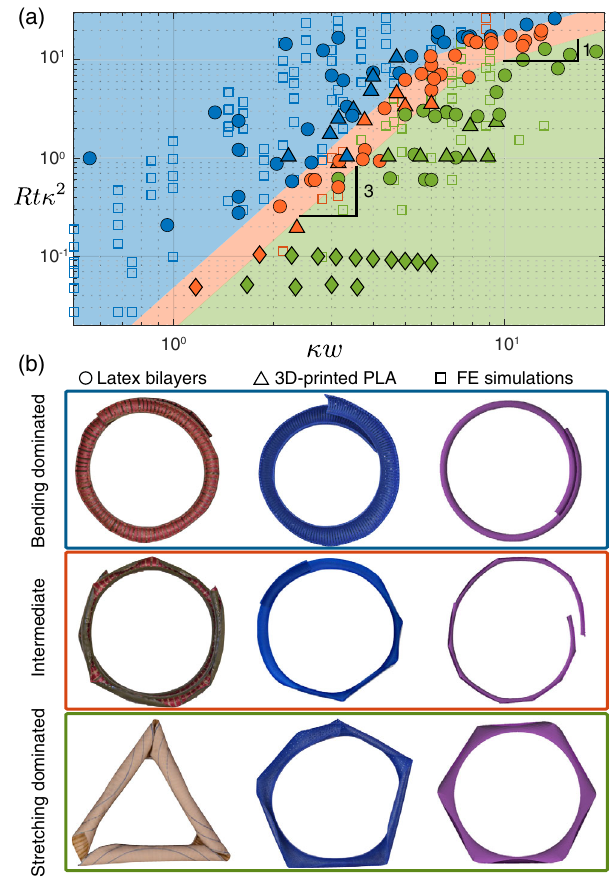
FIG. 2. Morphologies of radially curved ribbons. (a) Phase diagram of the three different types of observed shapes: toroidal (blue), intermediate (orange), and faceted (green). Full markers correspond to different experimental techniques: latex bilayers (circles), latex or polypropylene bilayers (diamonds), and 3D- printed PLA (triangles). Open markers correspond to finite- element (FE) simulation (see Sec. IV for more details on the experimental techniques and the simulation). (b) Examples of the observed morphologies: toroidal (top), intermediate (center), and faceted (bottom) for latex bilayers (left), 3D-printed PLA (center), and FE simulations (right). Movie 1 in Supplemental Material shows the deformation of 3D-printed ribbons when immersed in hot water